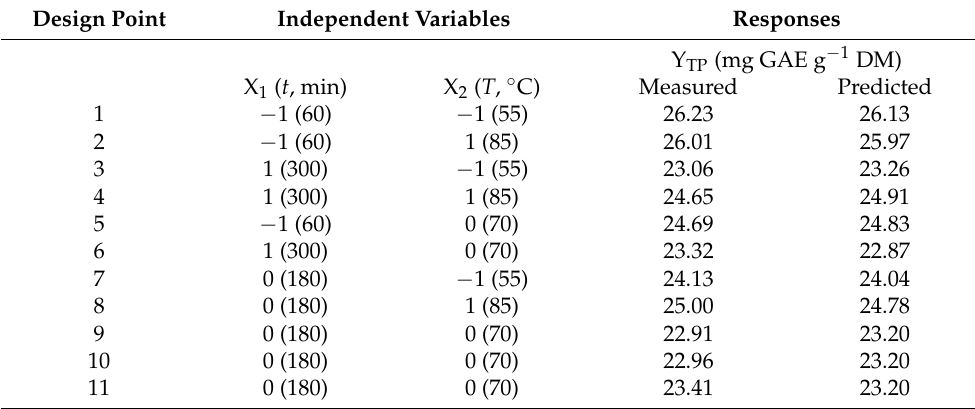
Figure 3. Statistical analyses pertaining to the response surface optimization of WOP aqueous polyphenol extraction. ( A ), desirability function; ( B ), plot showing actual vs. predicted Y TP values. The values marked with asterisks in the inset table “Parameter estimates” are statistically significant. The values in different color denote different level of significance. Pink area in B plot indicates the confidence interval of the model. Table 2. Measured and predicted values of the response (Y TP ) corresponding to the design points used for the response surface methodology.